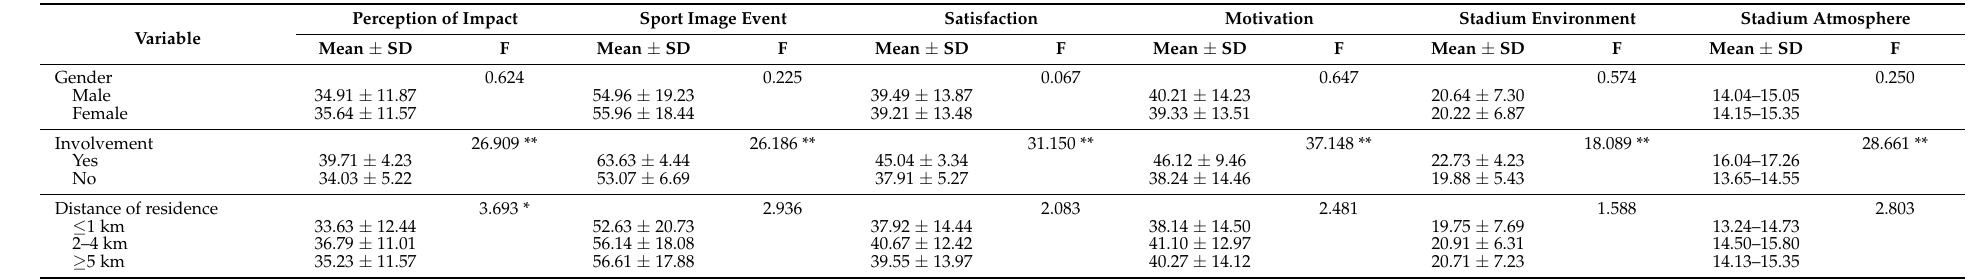
Table 6. Factors associated with response